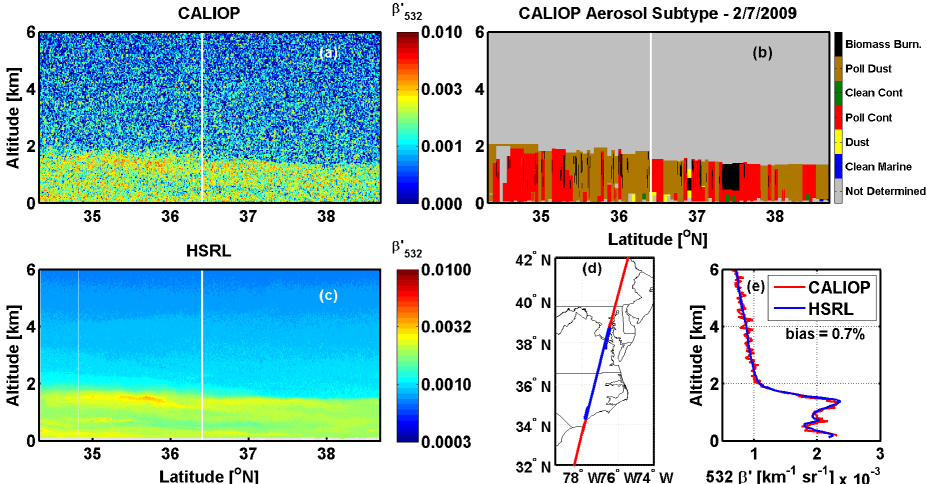
Figure 3. CALIOP (a) and HSRL (c) 532nm total attenuated backscatter time series for 7 February 2009 with the white vertical line denoting the point of closest approach. The flight tracks for HSRL (blue) and CALIOP (red) are also shown (d) . The mean attenuated backscatter profiles from HSRL (blue) and CALIOP (red) (e) show good agreement between the two. Finally, the CALIOP aerosol subtype product is shown (b) .